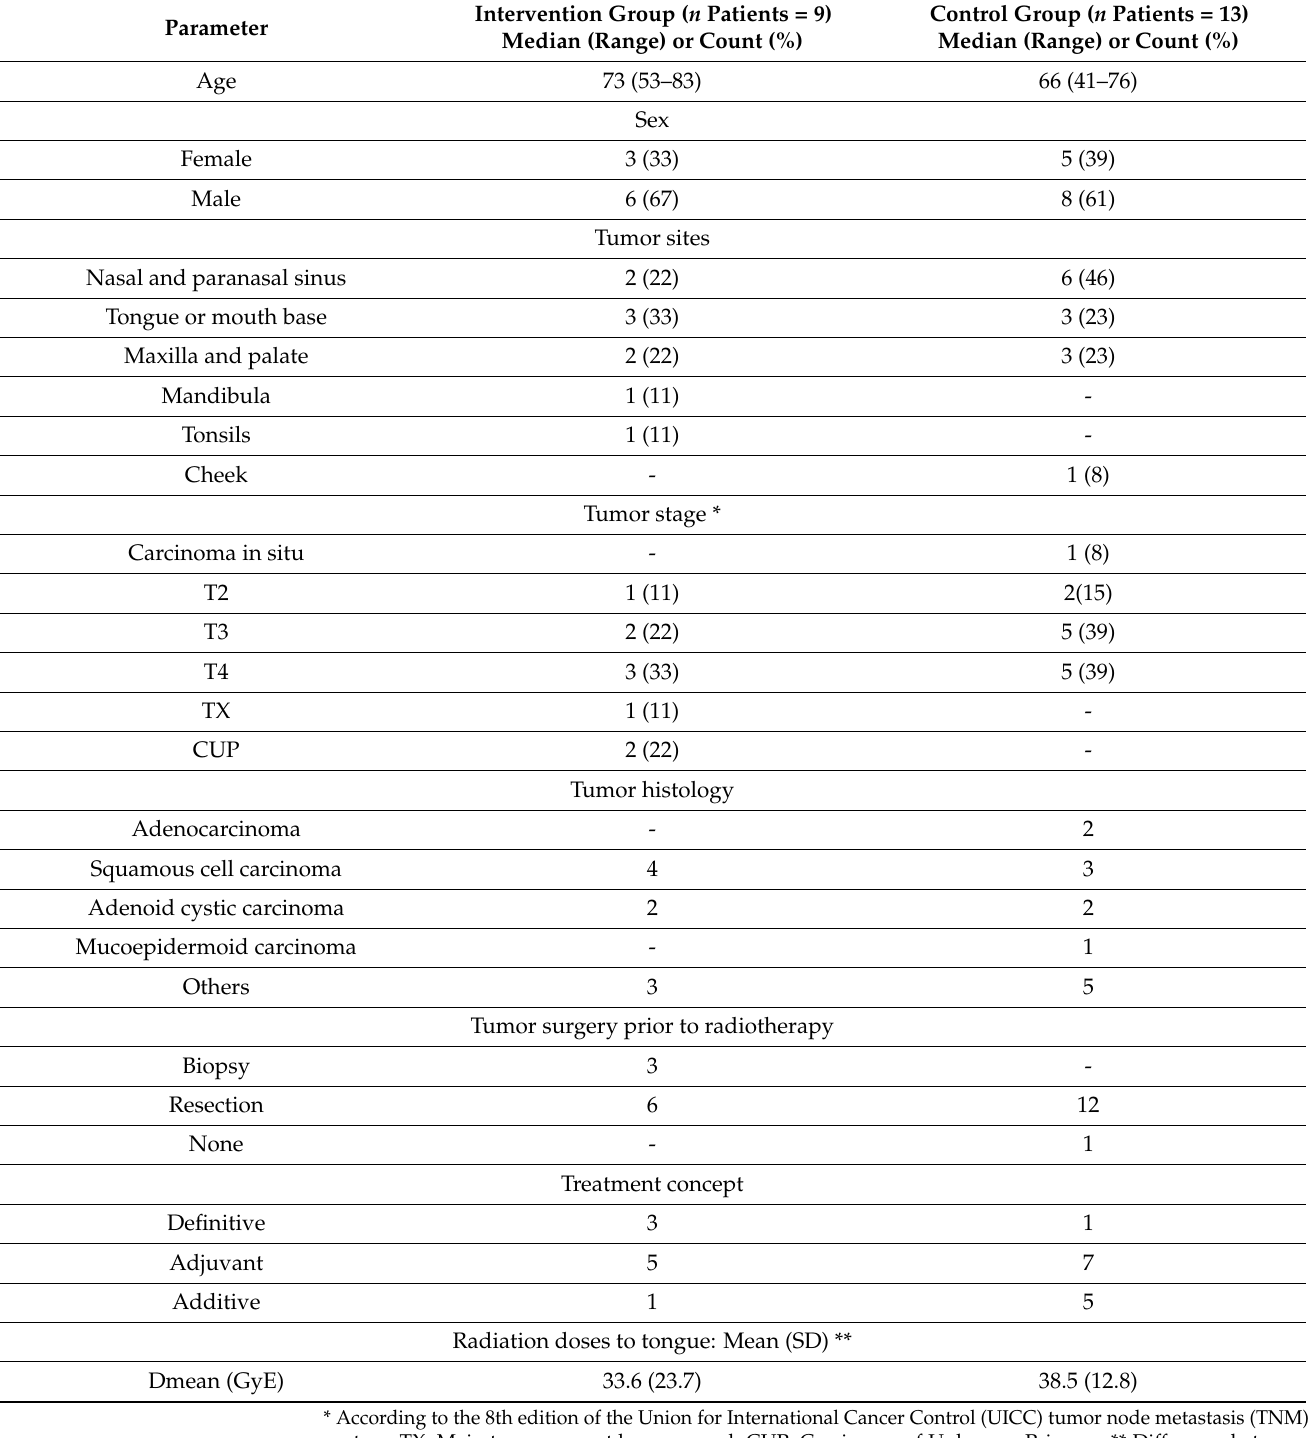
Table 1. Baseline characteristics of analyzed patients in the intervention group (tissue retracting device) and active control group (dental